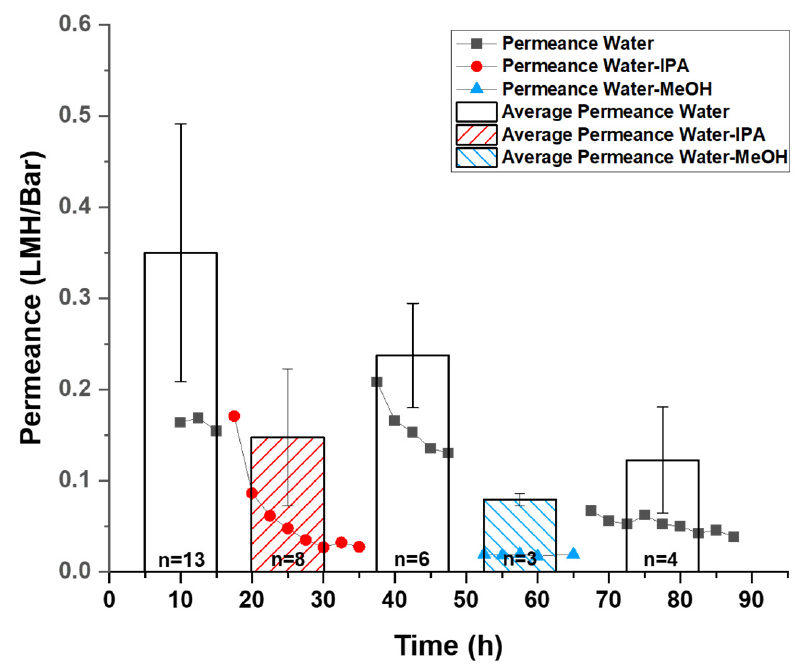
Figure 2. Pressure-driven permeance vs. time trend of the same GO membrane with different solvent mixtures (scatter plot) and average initial permeance calculated from tests on different membranes (columns). Water–alcohol (IPA or MeOH) mixtures are 1:1 v/v . The pressure applied was 10 psi. Each set of dots from the scatter plot shows the behavior of permeance in one continuous test with the solution mixture indicated by the legend. Between tests, solution mixtures were exchanged via syringes into the flow cell. The average permeance was calculated from “n” repeated tests under the same condition as described in the Experimental section. The number of tests, n, was labeled inside the corresponding columns.